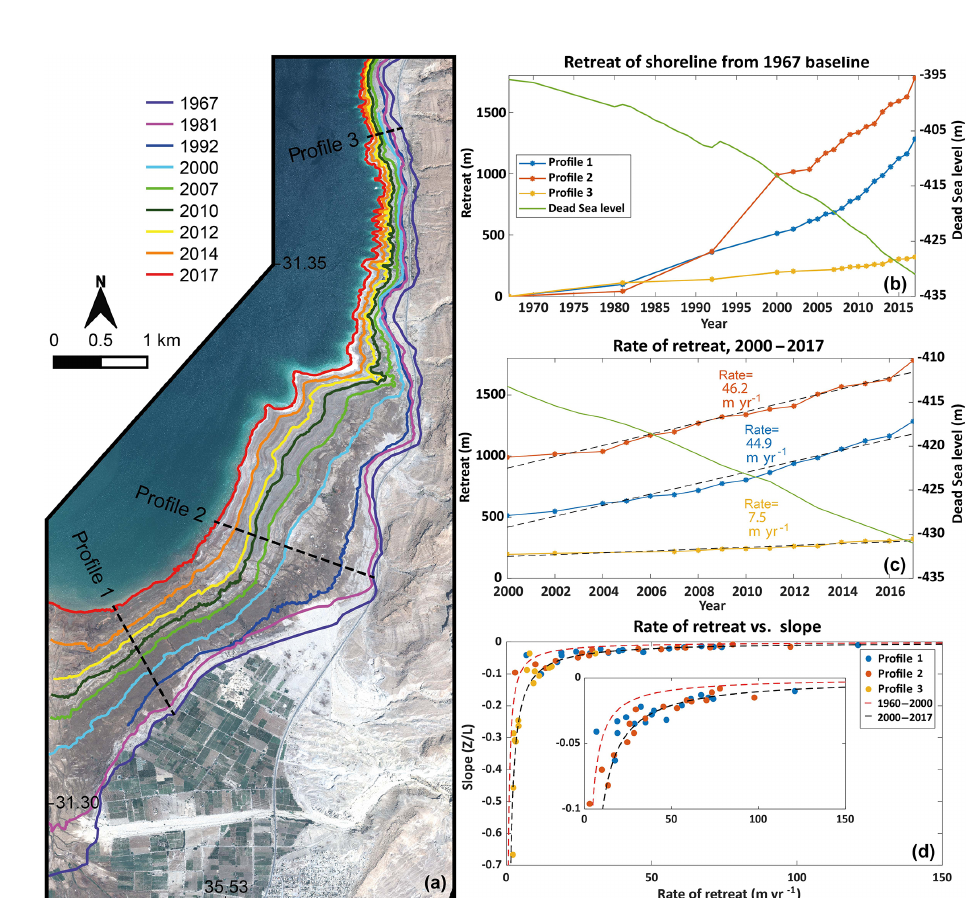
Figure 2. Dead Sea level fall and shoreline retreat in the Ghor Al-Haditha area of Jordan from 1967 to 2017. (a) Map of shoreline retreat with time, produced from satellite and aerial imagery. Also shown here are plots of the Dead Sea level and of the shoreline position along profiles in the Ghor Al-Haditha area over the periods: (b) 1967–2017 and (c) 2000–2017. (d) Plot of rate of shoreline retreat against bathymetric slope for profiles 1–3. The inset shows a close-up of the data from profiles 1 and 2 for clarity.